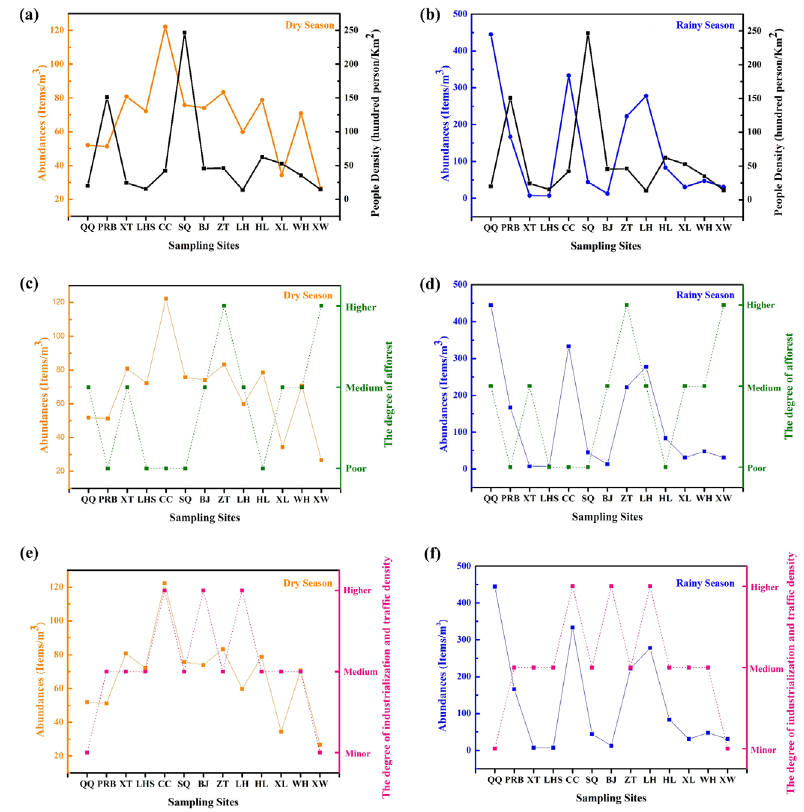
Figure 8. Correlations of microplastic abundances and the related socio-economic indicators. The applied socio-economic parameters were as follows: ( a , b ) population density (100 persons/km 2 ); ( c , d ) the degree of afforestation; ( e , f ) the degree of industrialization and traffic density. Note: QQ, Qingqi; PRB, Pearl River Bridge; XT, Xiaotang; LHS, Lianhuashan; CC, Chencun; SQ, Shiqiao; BJ, Beijiao; ZT, Zuotan; LH, Lanhe; HL, Hengli; XL, Xiaolan; WH, Waihai; XW, Xinwei.